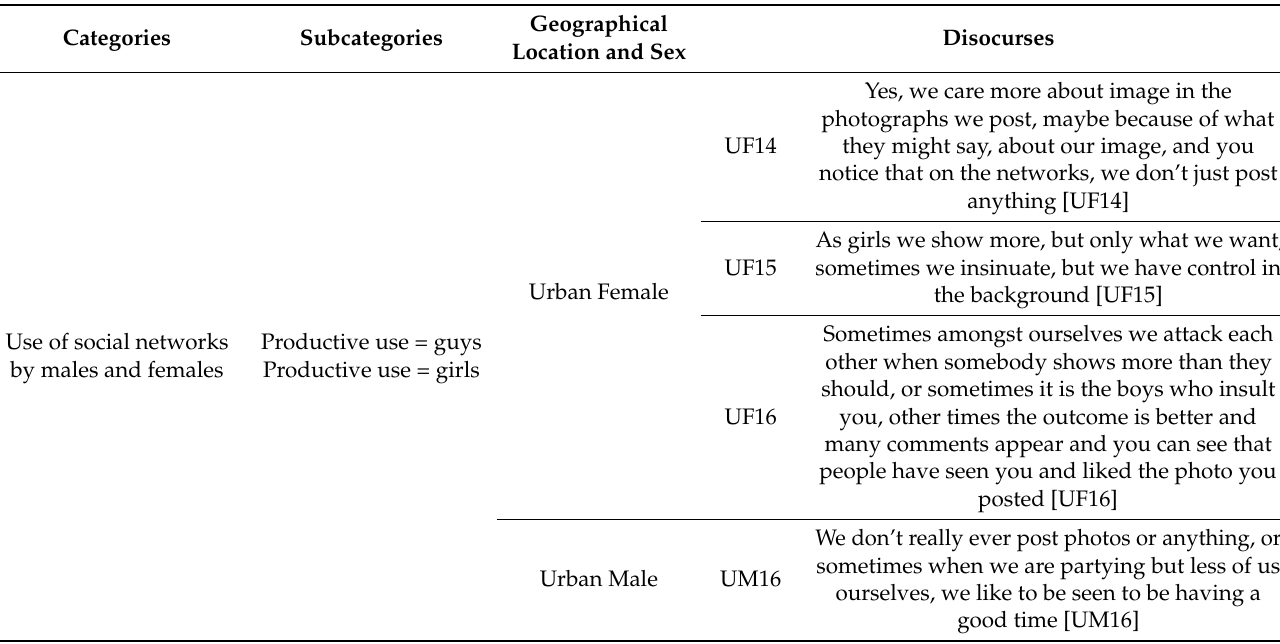
Table 8. Images relating to their body and aesthetic beauty.